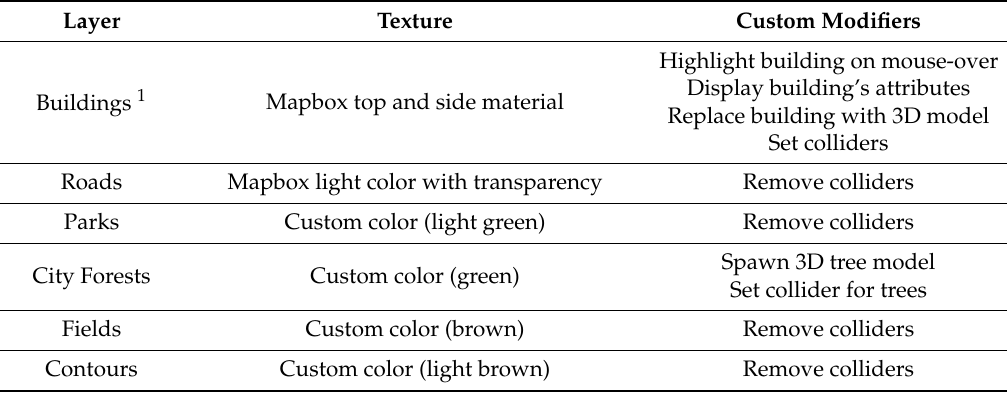
Figure 4. Map abstraction for Mapbox Unity3D. Table 1. Configurations for each Mapbox Tileset